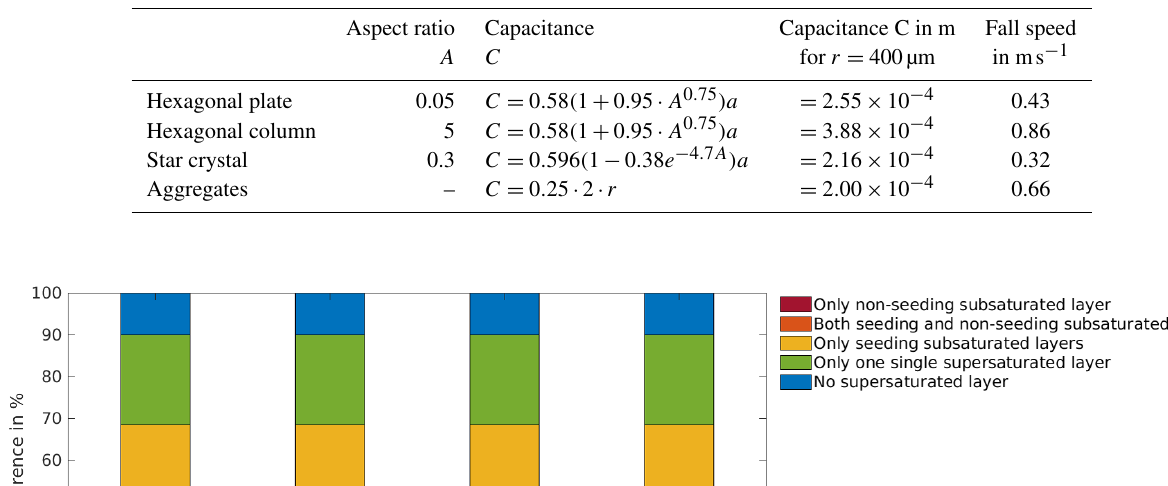
Table A1. Calculation of capacitance based on Westbrook et al. (2008). The listed ice crystal shapes correspond to the selected particles’ hexagonal plates, rimed long columns, crystal with sector-like branches and assemblages of planar polycrystals respectively (Mitchell, 1996). 2 a refers to the maximum span across the basal/hexagonal face (Westbrook et al., 2008). In the case of the hexagonal plate and the star crystal this is a = r . In the case of a hexagonal column it is a = 2 r/A , with 2 r being the maximum dimension. The fall speed is calculated using r = 400µm, T = 253 . 15K and p = 1013 . 15hPa.